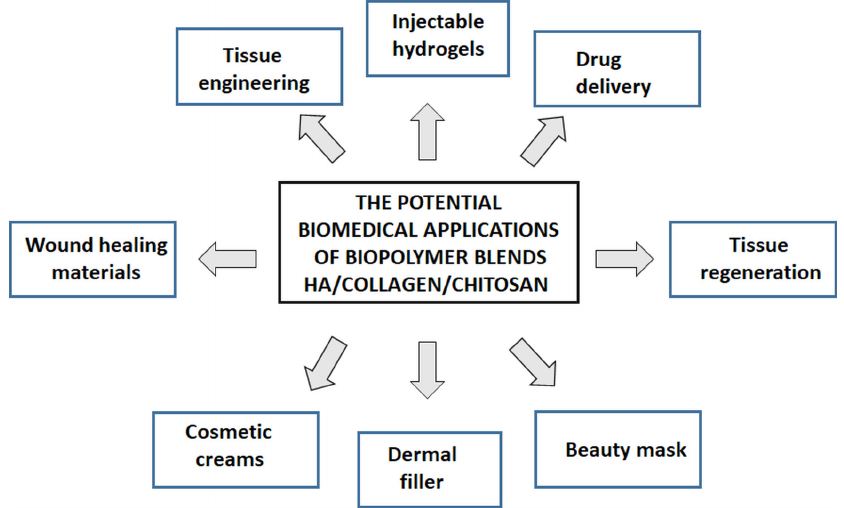
Figure 8. Potential applications of biopolymer blends base of HA, collagen, and chitosan.